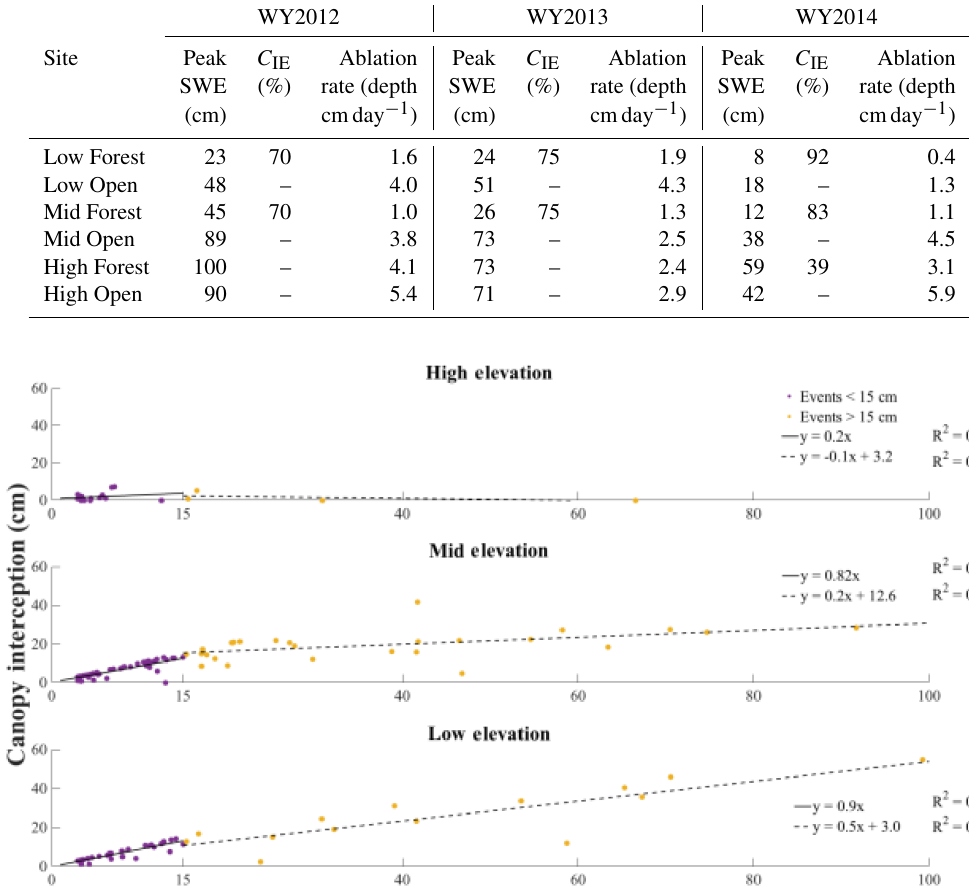
Figure 3. Canopy interception depth vs. event snowfall within the ForEST network.